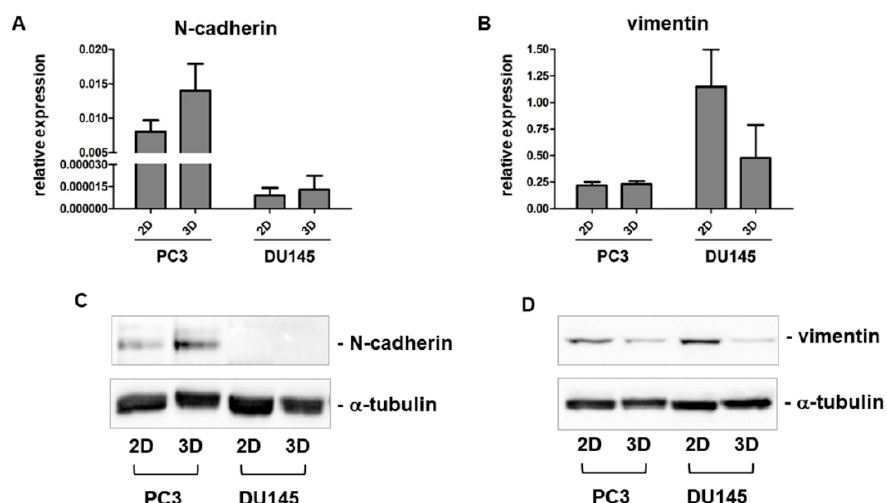
Figure 5. N-cadherin and vimentin mRNA and protein levels. Bar graphs showing N-cadherin ( A ) and vimentin ( B ) mRNA levels in PC3 and DU145 cells grown in 2D-monolayers and 3D cell cultures. Data are means ± SD of duplicate samples. Representative Western blot analysis showing N-cadherin ( C ) and vimentin ( D ) protein levels in whole cell lysates obtained from PC3 and DU145 cells cultured in both experimental conditions.